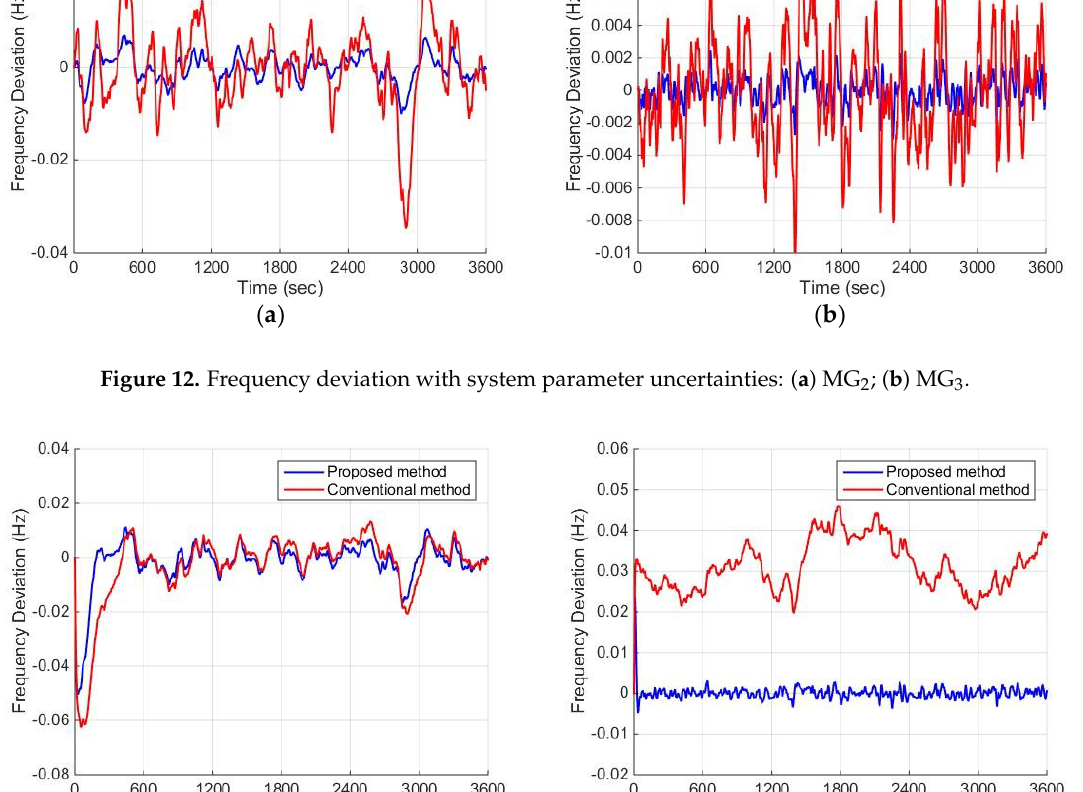
( b ) Figure 14. Power transmission between two adjacent MGs. ( a ) power transmission between MG  and MG  ; ( b ) power transmission between MG  and MG  . Figure 15. Power transmission between power grid (PG) and MG  .